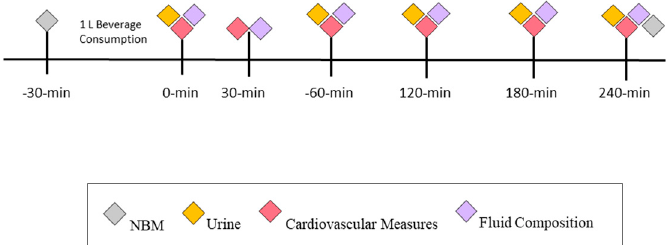
Figure 1. Timeline of measurements. Nude body mass (NBM) was recorded upon arrival followed by the ingestion of 1 L of either distilled water (DW) or isotonic beverage (IB). Either 1 L distilled water (DW) or isotonic beverage (IB) over the course of 30 min. Urine output was measured immediately after fluid consumption and every 60 min for 240 min. Cardiovascular and fluid composition was assessed immediately following, 30 min, and every 60 min following fluid consumption for 240 min.